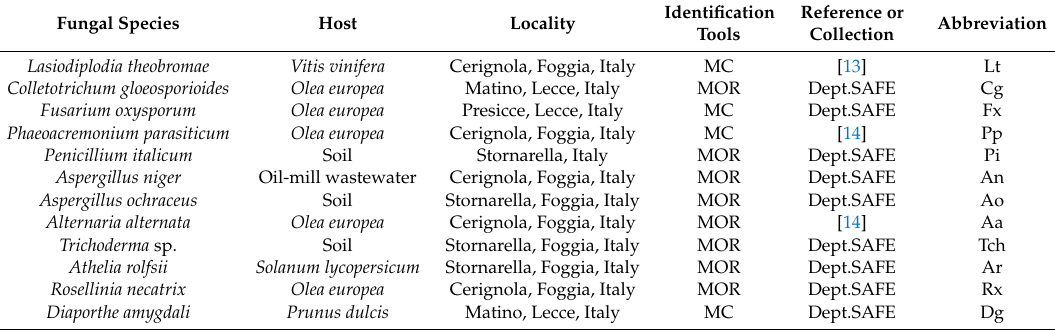
Table 1. Details of the fungal species used in this study. MC, molecular characterization; MOR, morphological and microscopic characterization; Dept. SAFE, Department of the Science of Agriculture, Food, and Environment, University of Foggia, Foggia,